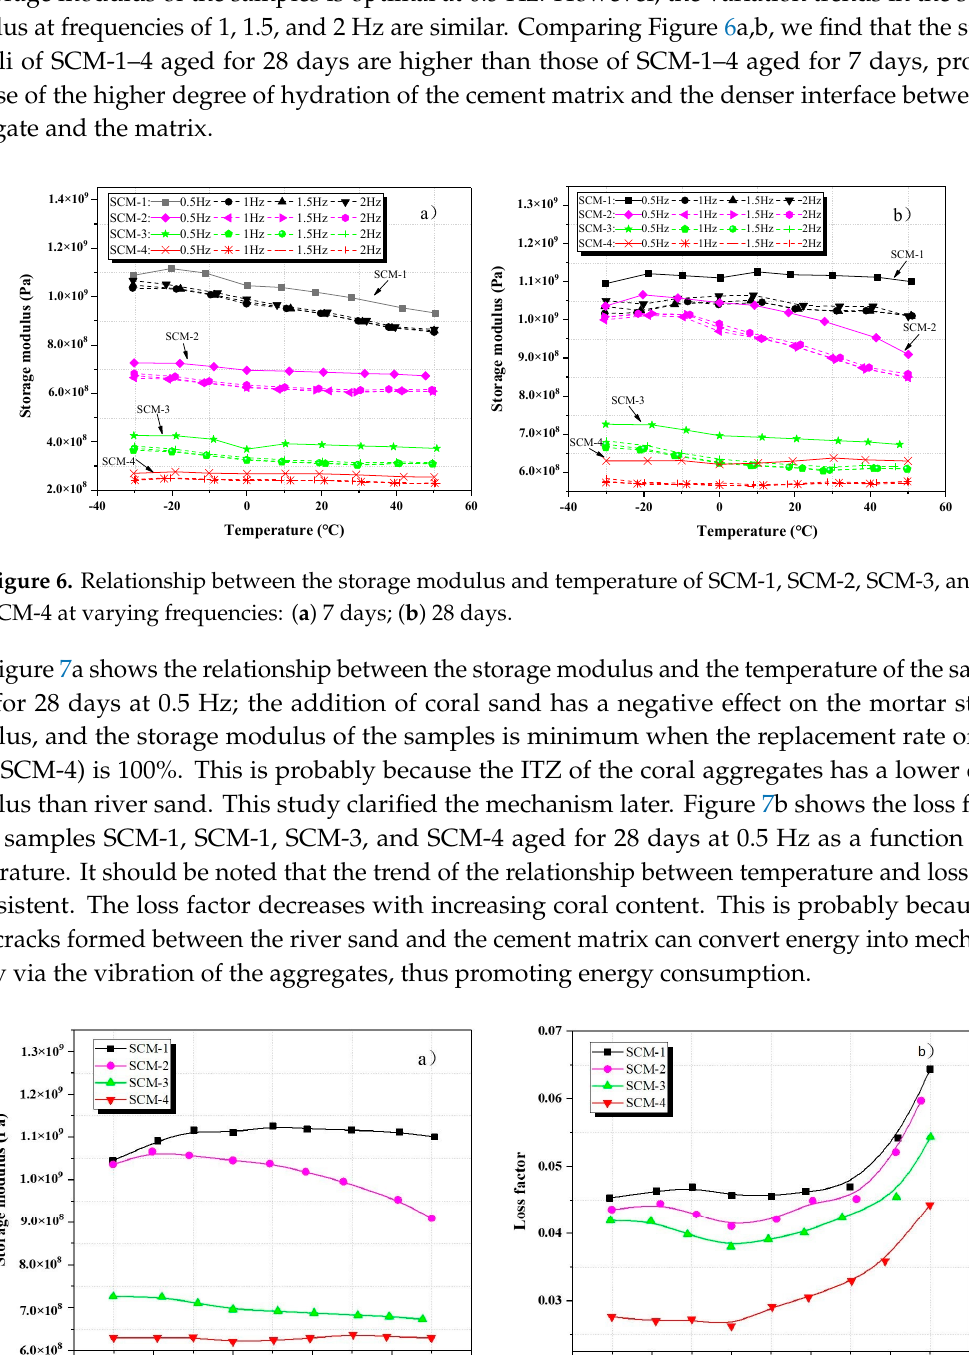
Figure 7. Samples under varying coral sand replacement rates and temperature for frequency of 0.5 Hz at 28 days: ( a ) Storage modulus; ( b ) loss